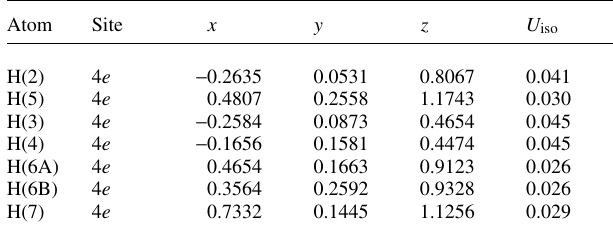
Table 2. Atomic coordinates and displacement parameters (in Å 2 )